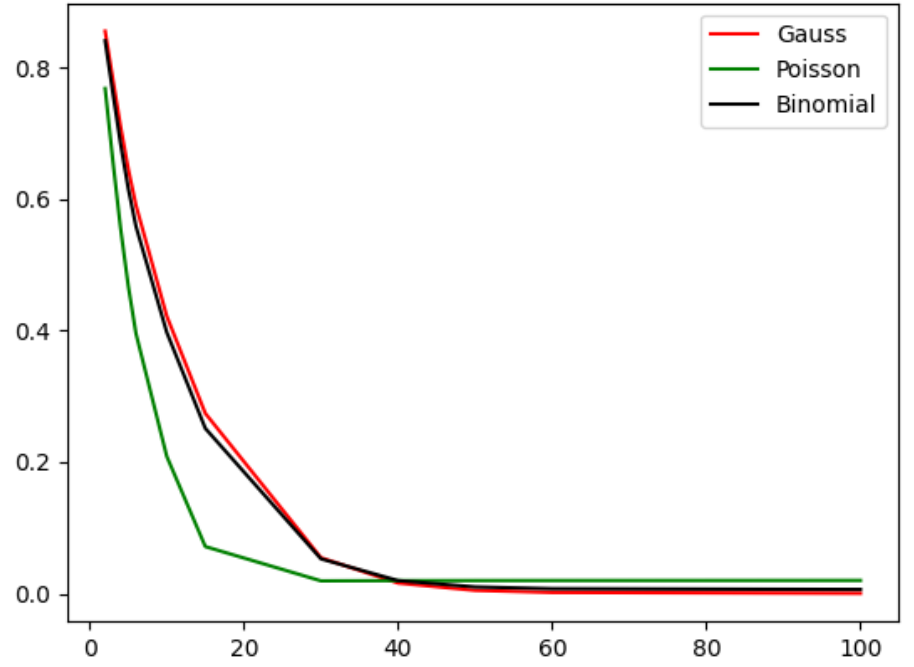
Figure 5. Total variational distance between the approximated and the exact degree distribution in the function of cluster numbers, where the IRG is generated using the Range ( 3000 ) parametrization and the clusters are given by C S ( V )